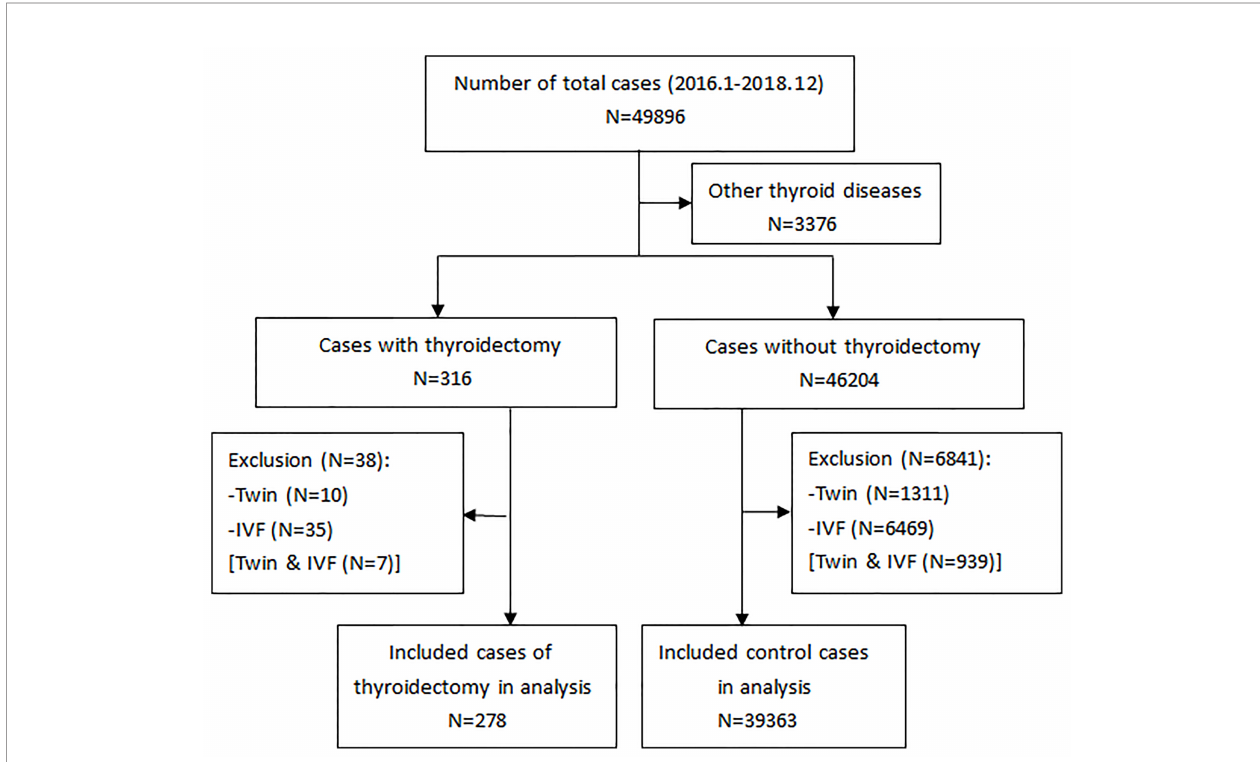
FIGURE 1 | A fl owchart of the study selection. Other thyroid diseases (in the second box) include hyperthyroidism, hypothyroidism, thyroiditis, surgery for benign thyroid nodule, and medication use for thyroid